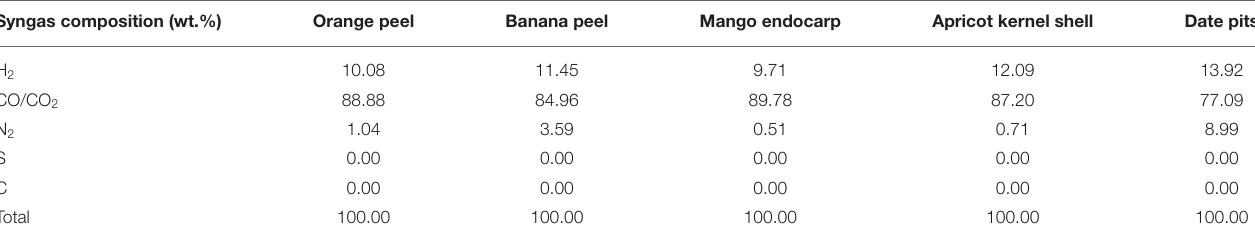
TABLE 6 | The syngas composition of the selected fruit wastes. Syngas composition